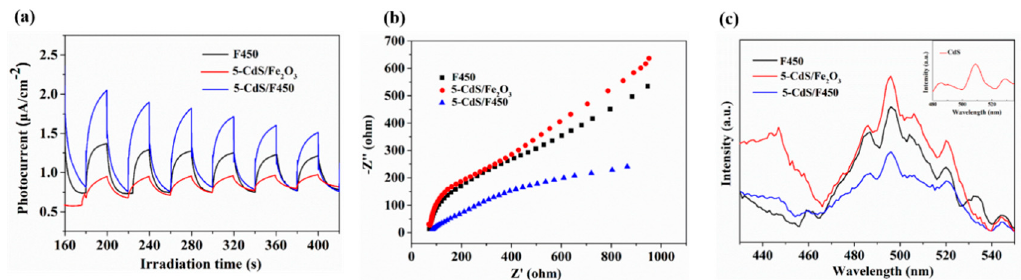
Figure 9. ( a ) Transient photocurrent response; ( b ) Nyquist impedance plots; ( c ) steady-state PL emission spectra of the samples.